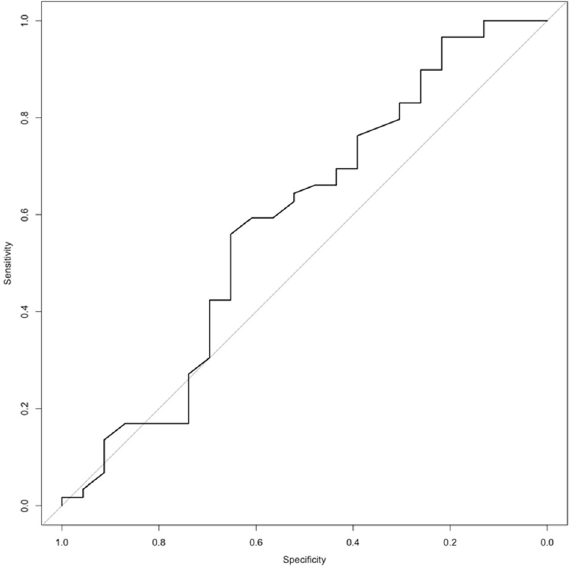
Figure 1. Receiver-operating-characteristic (ROC) curve demonstrating the association between maximum tumor diameter and entity (AUC 0.585, 95%-confidence interval 0.434–0.735). maximum tumor diameter and entity (AUC 0.585, 95%-confidence interval